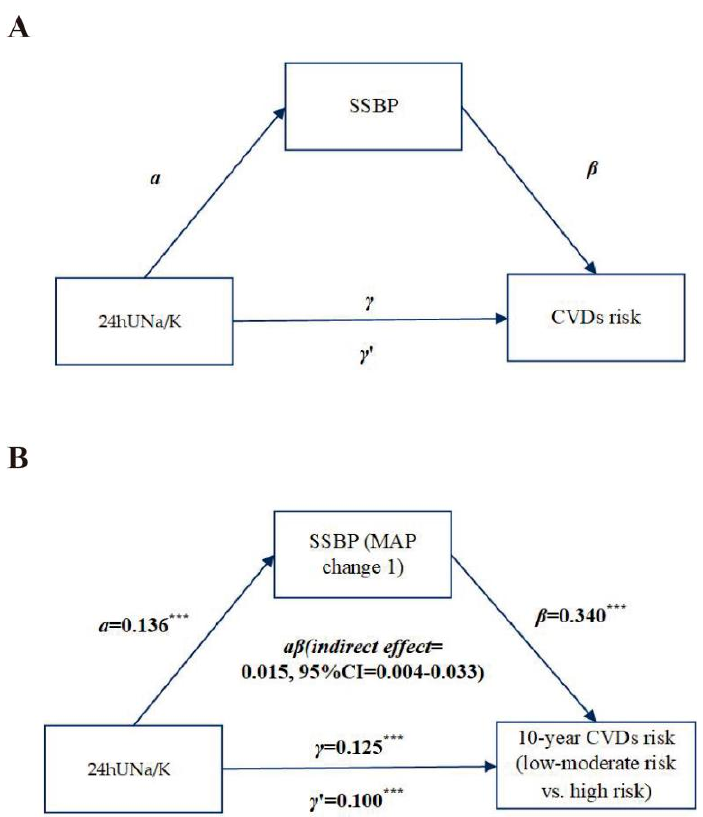
Figure 2. Mediation effect of SSBP between Na/K ratio and 10-year CVD risk. Illustration diagram of regression analysis steps necessary to conduct a simple mediation model ( A ). Mediation effect of SSBP between 24hUNa/K and the 10-year CVD risk ( B ). Footnote: unstandardized regression coefficients ( 𝜏 , 𝜏 ’, α , and β ) were used in the model. The regression coefficient between 24hUNa/K and the 10-year CVD risk, controlling for SSBP, is indicated as 𝜏 ’ (direct effect) while the regression coefficient between 24hUNa/K and the 10-year CVD risk only (total effect) is indicated as 𝜏 . ***: p < 0.001.